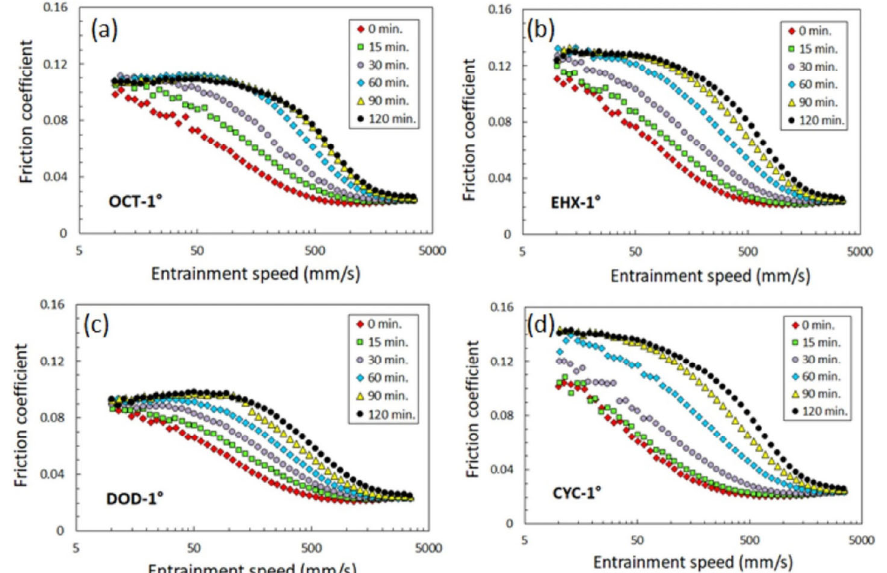
Fig. 19 Evolution of friction coefficient versus entrainment speed curves during 2-h slow speed rolling-sliding tests for solutions of four primary ZDDPs. (a) Oct-1-yl ZDDP, (b) 2-ethylhexyl ZDDP, (c) dodec-1-yl ZDDP, and (d) cyclohexylethyl ZDDP [228]. Reproduced with permission from Ref. [228], © The author(s), 2021.